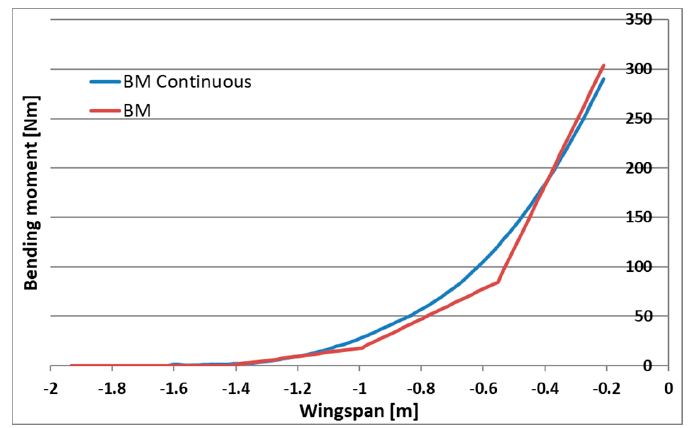
Figure 8. Bending moment distribution for continuous and applied loading.